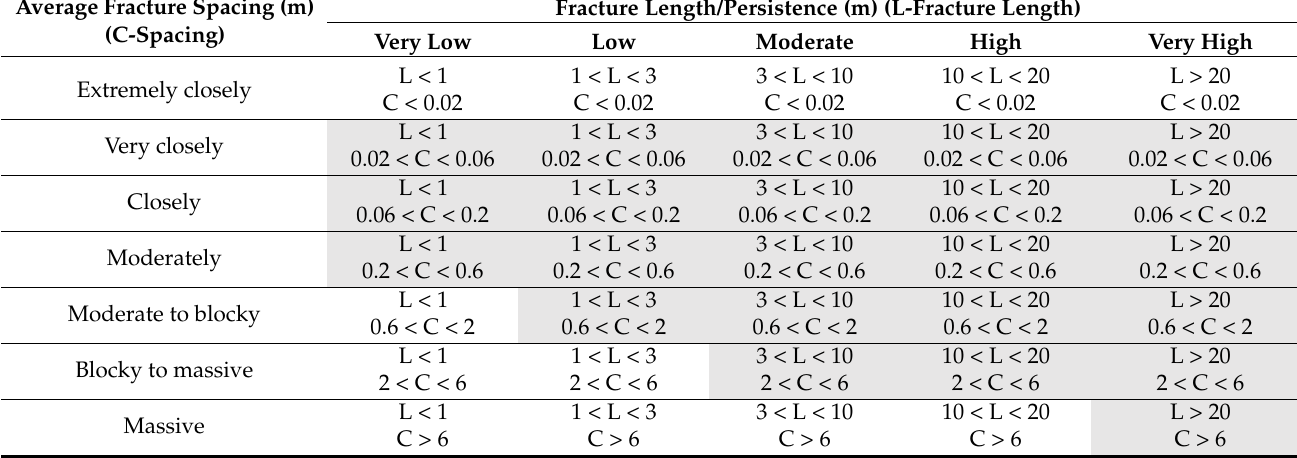
Table 1. Classification of fractured rock mass according to spacing and extensibility (L-fracture length,